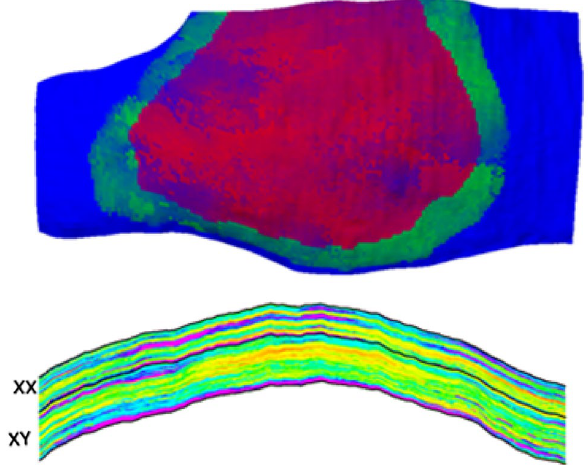
Fig. 8 Top view of 3‑phase saturation distribution (top), gas (red), oil (green) saturation. East–west cross‑section of permeability distribu‑ tion